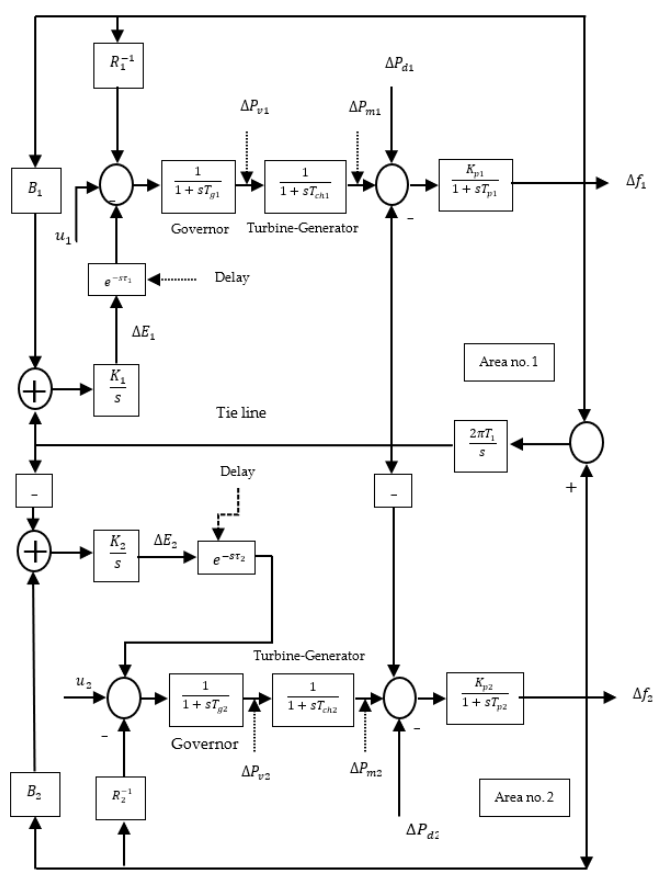
Figure 1. A two-area system and its electrical equivalent circuit representation.